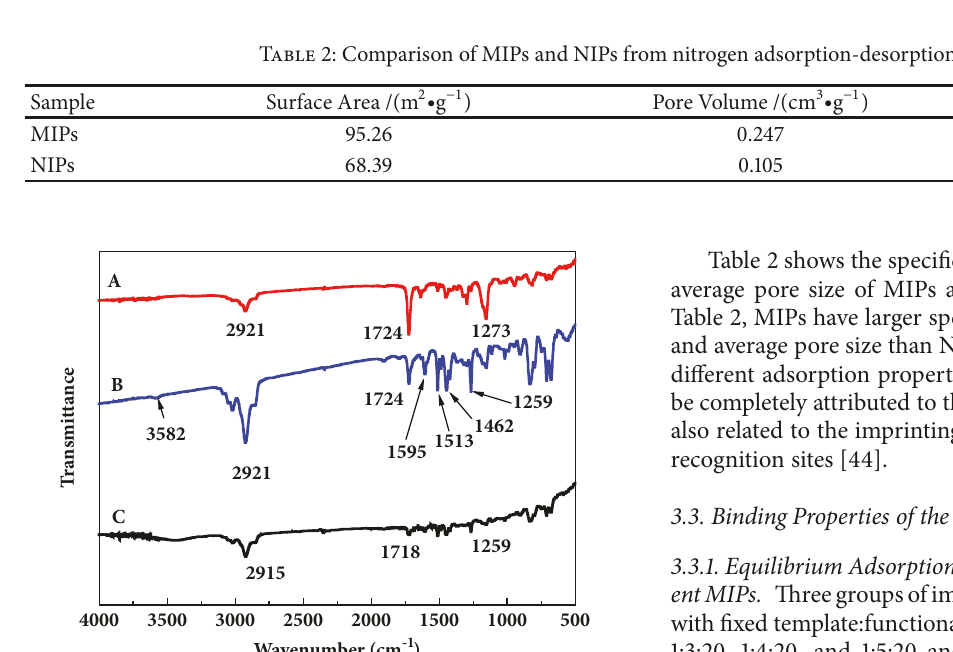
microspheres, (B) uneluted VBC-DVB